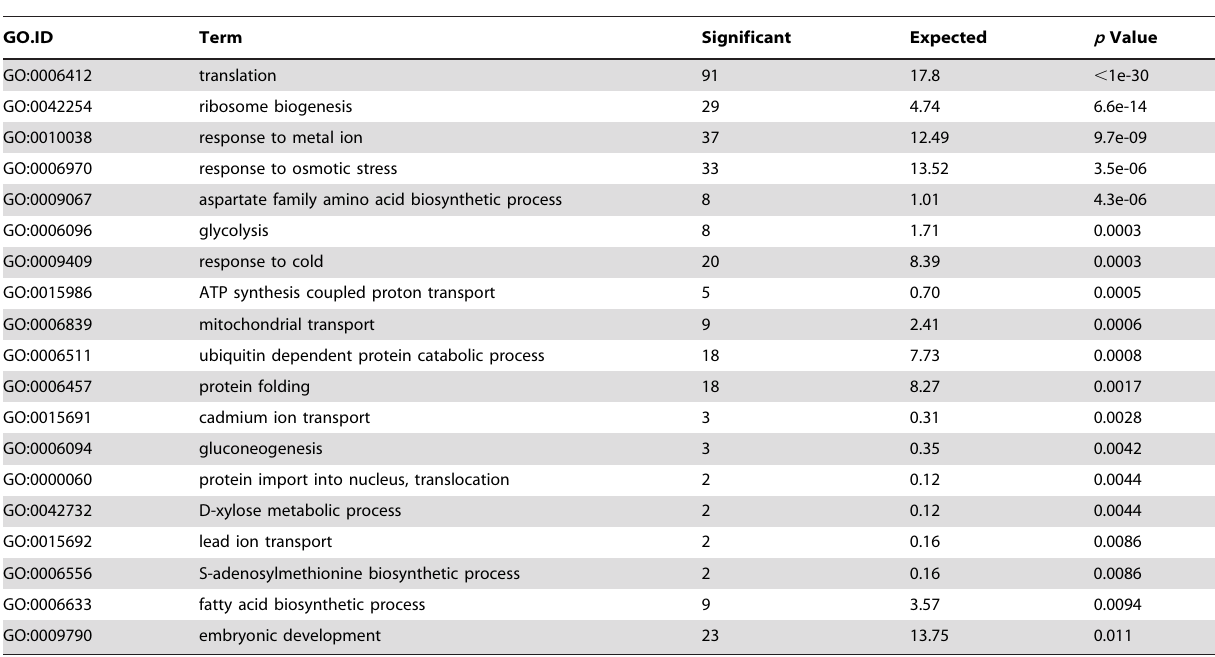
Table 1. Gene ontology analysis.